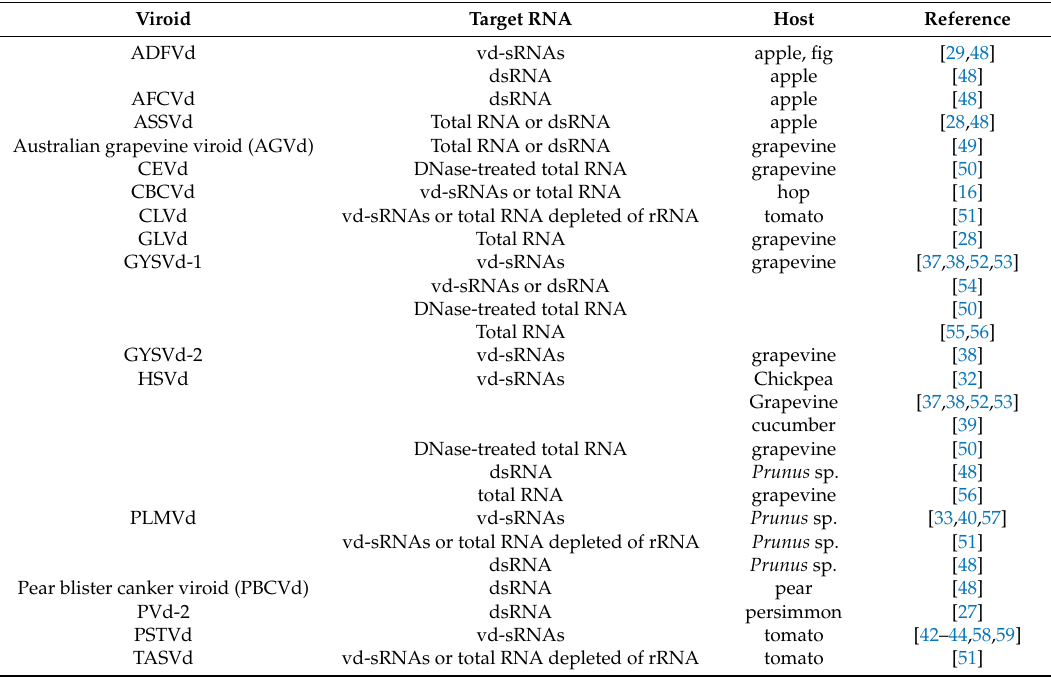
Table 5. Detection and identification of viroids in host plants by